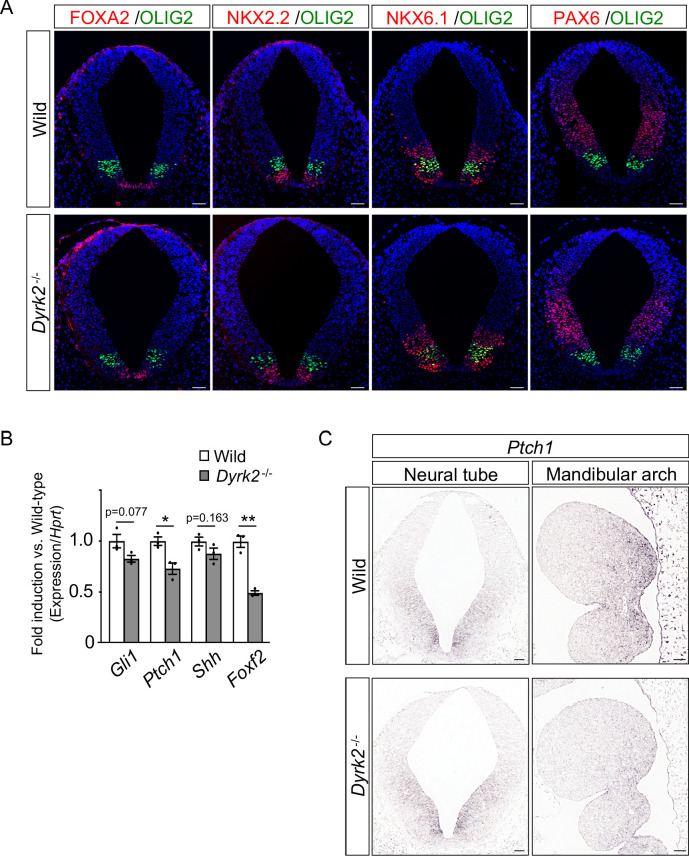
Dorsal-ventral patterning of the neural tube in Dyrk2-/- mice.(A) Transverse sections of wild-type and Dyrk2-/- embryos at E10.5 (at the branchial level) were stained for markers of ventral (FOXA2, NKX2.2, OLIG2, and NKX6.1) and dorsal (PAX6) regions. Nuclei were stained with DAPI (blue). (B) qPCR of Gli1, Ptch1, Shh, and Foxf2 in the whole embryos from wild-type and Dyrk2-/- embryos at E9.5. Data are presented as the means ± SEM (n = 3 biological replicates). The statistical significance between wild-type and Dyrk2-/- was determined by the Student’s t-test. (*) p<0.05, (**) p<0.01. (C) In situ hybridization of Ptch1 in the neural tube (left panels) and mandibular arch (right panels) in wild-type and Dyrk2-/- embryos at E10.5 from the transverse and sagittal plane, respectively. Scale bars, 50 µm.Figure 2—figure supplement 1—source data 1.Source data for Figure 2—figure supplement 1B.